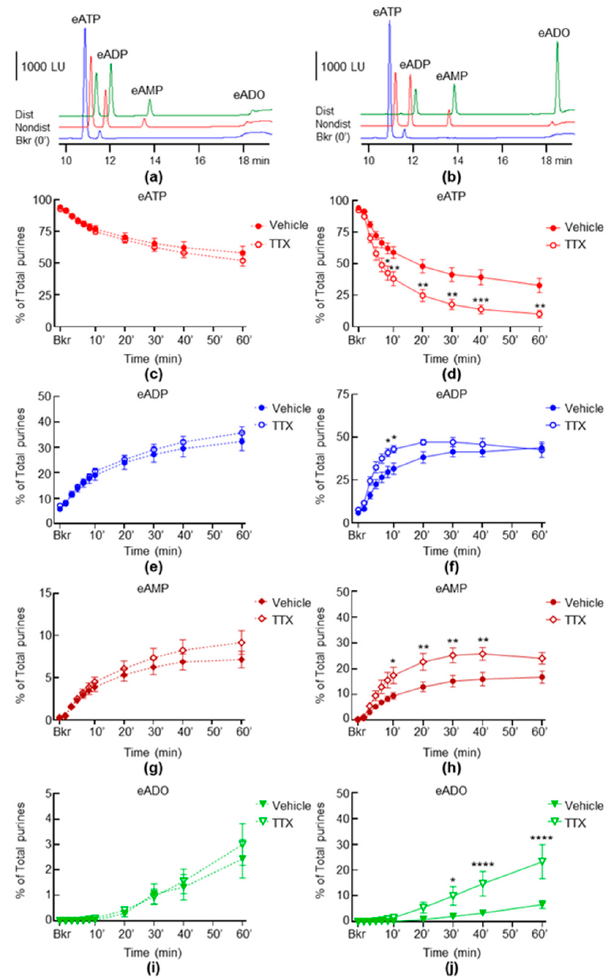
Figure 2. Effects of TTX on the hydrolysis of eATP by s-ENTDs released in cELS of nondistended and distended detrusor-free bladder preparations. Original chromatograms of eATP in beaker (Bkr, blue, 0 ′ , no enzyme present) and at 60 min of enzymatic reaction in cELS of nondistended (Nondist, red) and distended (Dist, green) bladder preparations treated with vehicle ( a ) or TTX ( b ). LU, luminescence units. Summarized data showing changes in eATP, eADP, eAMP and eADO in the presence of vehicle (Krebs bicarbonate solution, KBS, n = 8) or TTX 0.5 µ M ( n = 6) in nondistended ( c , e , g , i ) and distended ( d , f , h , j ) bladder preparations; n , number of bladder preparations. eATP, eADP, eAMP and eADO are presented as percentages of total purines (eATP + eADP + eAMP + eADO) present in reaction solutions. Asterisks denote significant difference from vehicle controls. * p < 0.05, ** p < 0.01, *** p < 0.001, **** p < 0.0001. Two-way ANOVA with Sidak’s multiple comparisons